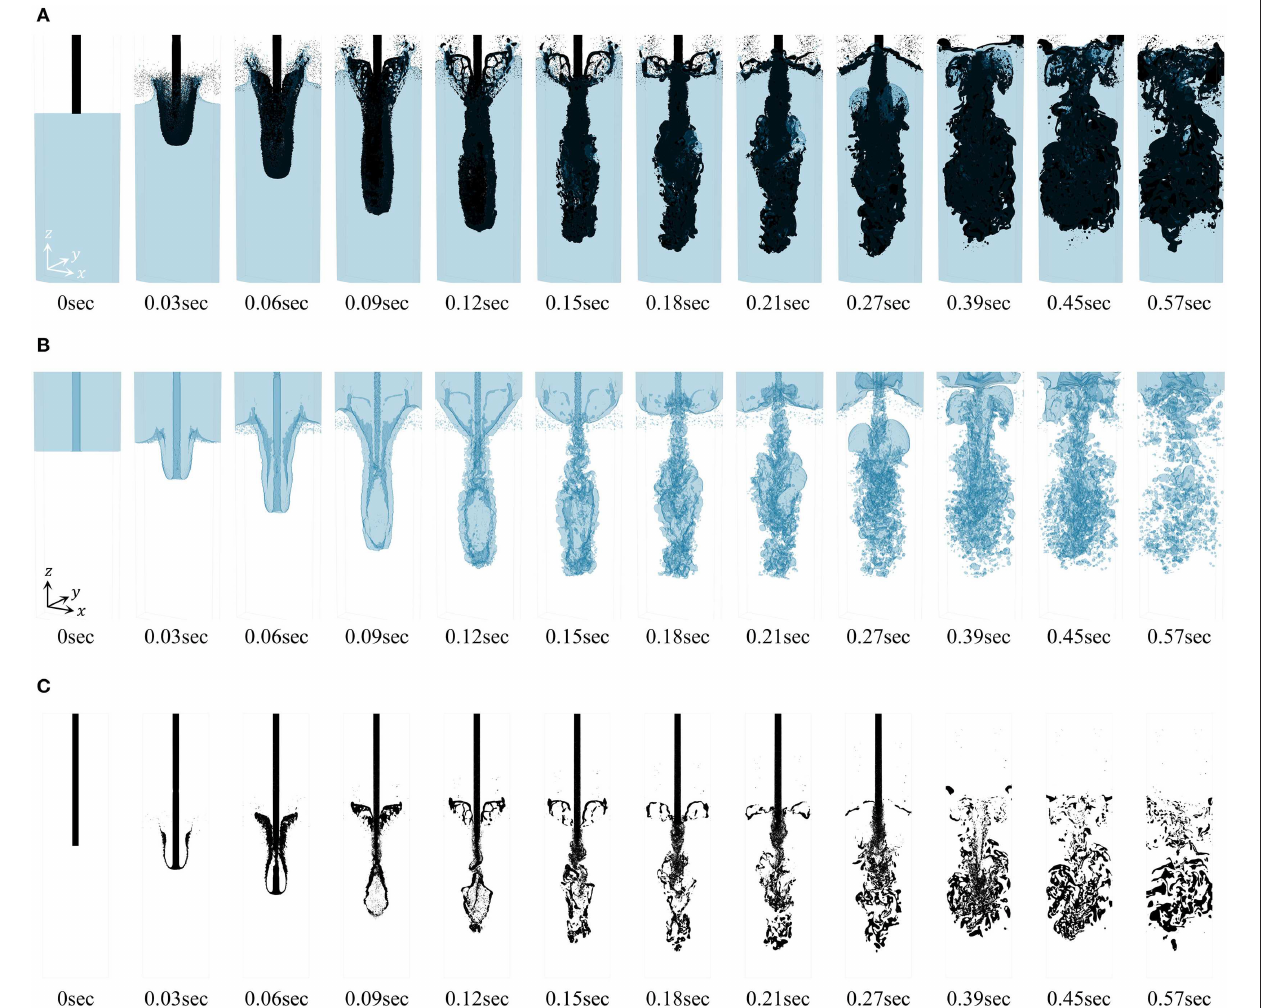
FIGURE 8 | Snapshots of two-phase simulation of jet breakup: (A) two fluids with rendering (blue for the Fluorinert pool, and black for the water jet), (B) air with rendering, and (C) jet breakup behavior at the x–z